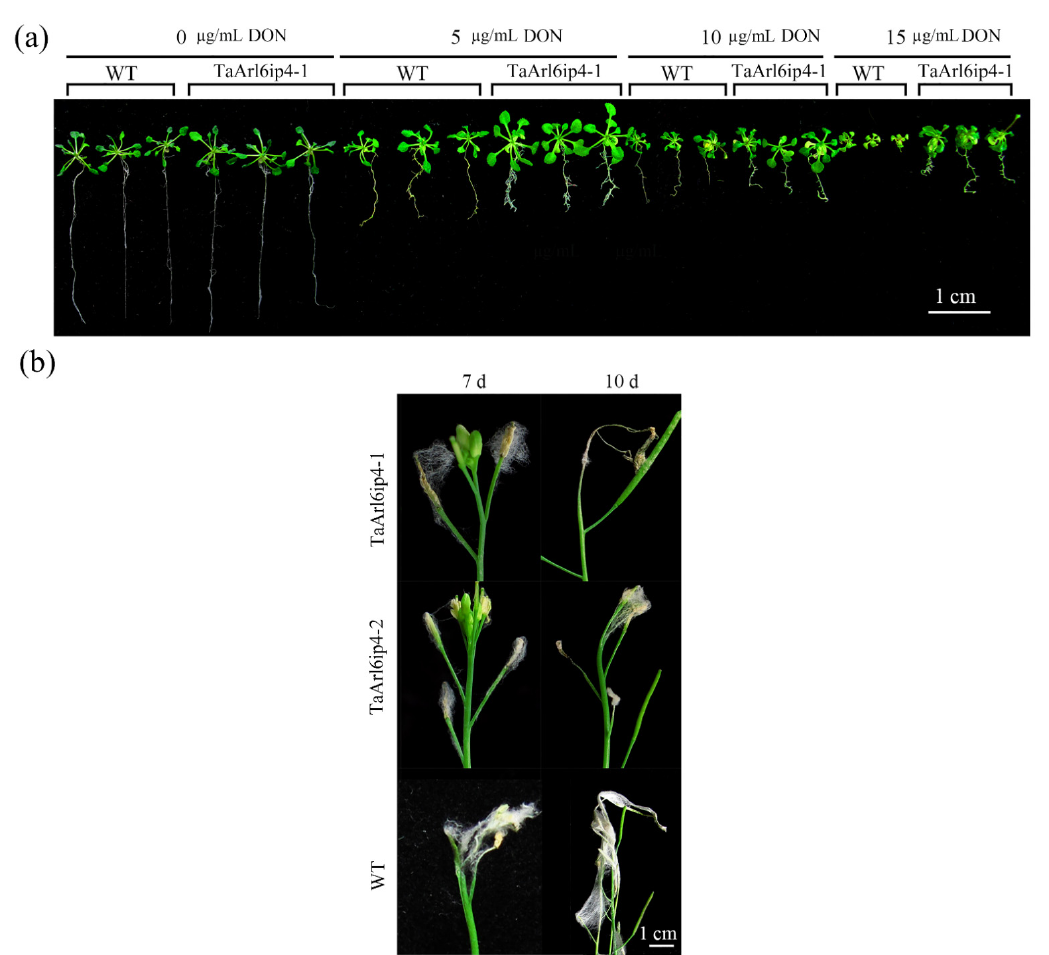
Figure 6. TaArl6ip4 confers transgenic plants DON tolerance and FHB resistance. ( a ) Phenotypes of T 2 generation transgenic Arabidopsis TaArl6ip4 -1 and wild-type Arabidopsis (WT) seedlings were germinated in 1/2 MS medium after treatment with 0, 5, 10, or 15 µg mL − 1 of DON. Photographs were taken at 14 days post inoculation with DON (Bar = 1 cm). ( b ) Phenotypes of florets from T 3 generation transgenic Arabidopsis lines ( TaArl6ip4 -1 and TaArl6ip4 -2) and wild-type (WT) at 7 and 10 days post inoculation with F. graminearum 5035 (Bar = 1 cm). The experiments were performed using 60 plants from either transgenic lines or wild-type genotypes.